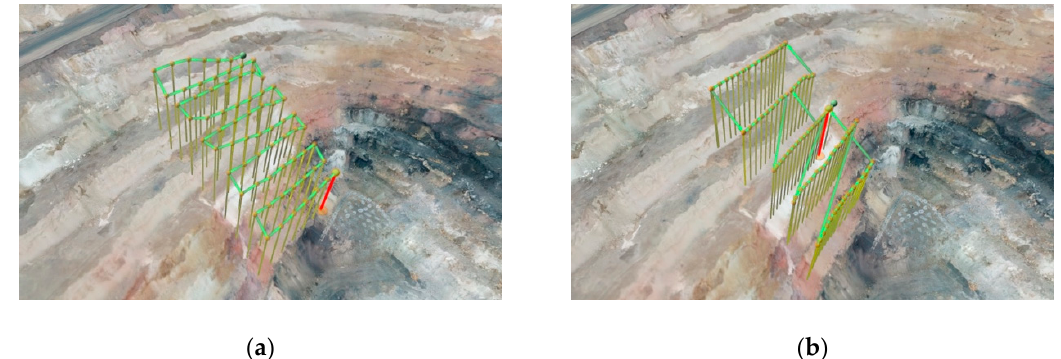
Figure 15. Illustrations of (a) parallel path for R1; (b) optimum path for R1.